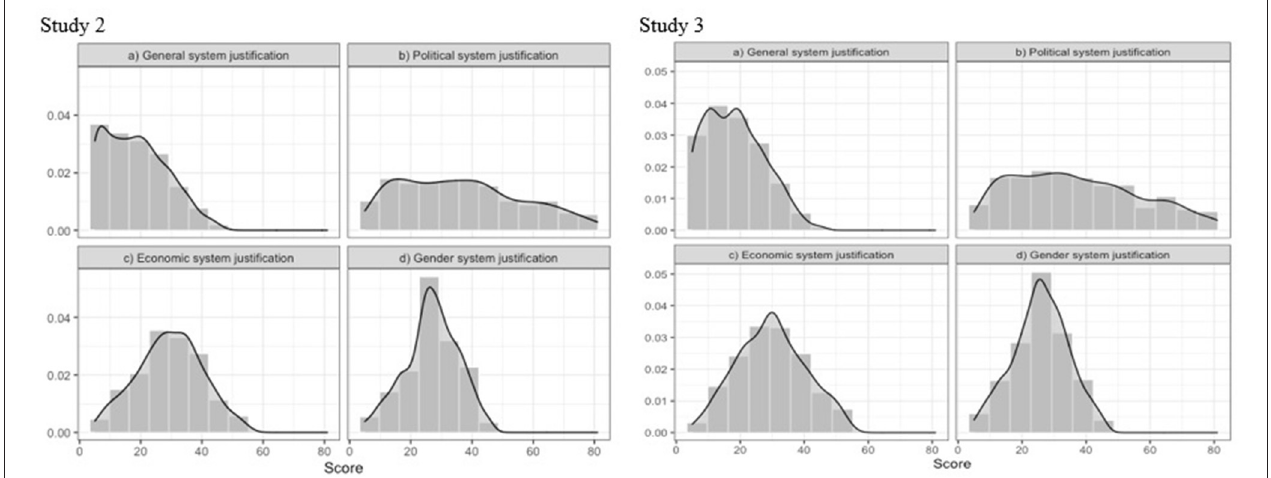
FIGURE 1 | Distribution of the total score of SJ scales from Study 2 and Study